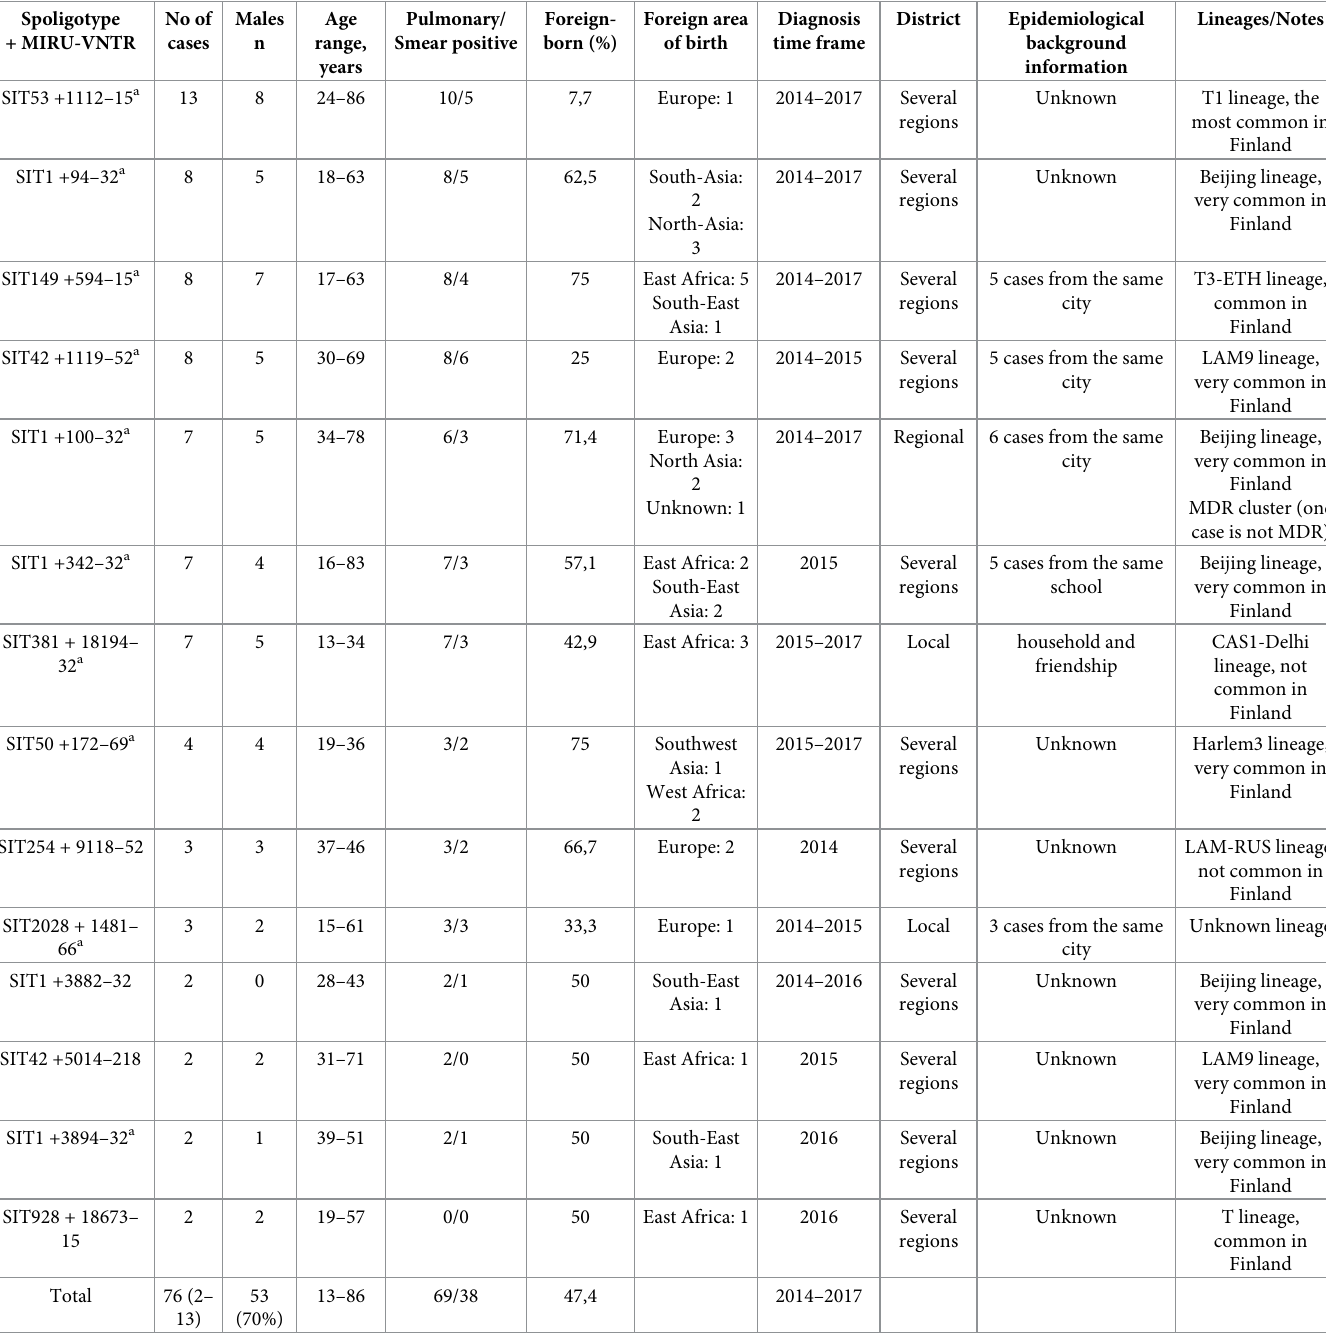
Table 3. Characteristics of TB transmission patterns in clusters including both Finnish-born and foreign-born cases in Finland, 2014–2017. Spoligotype +